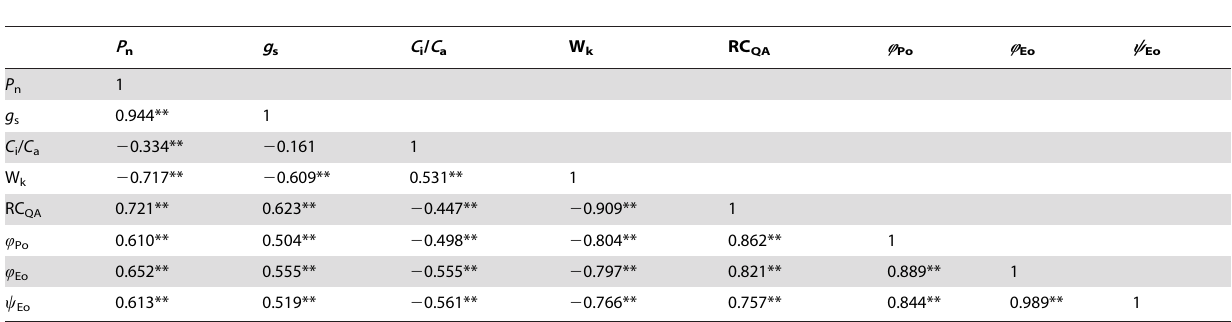
Table 1. Correlation among different parameters of gas exchange and chlorophyll a fluorescence under low sink demand.